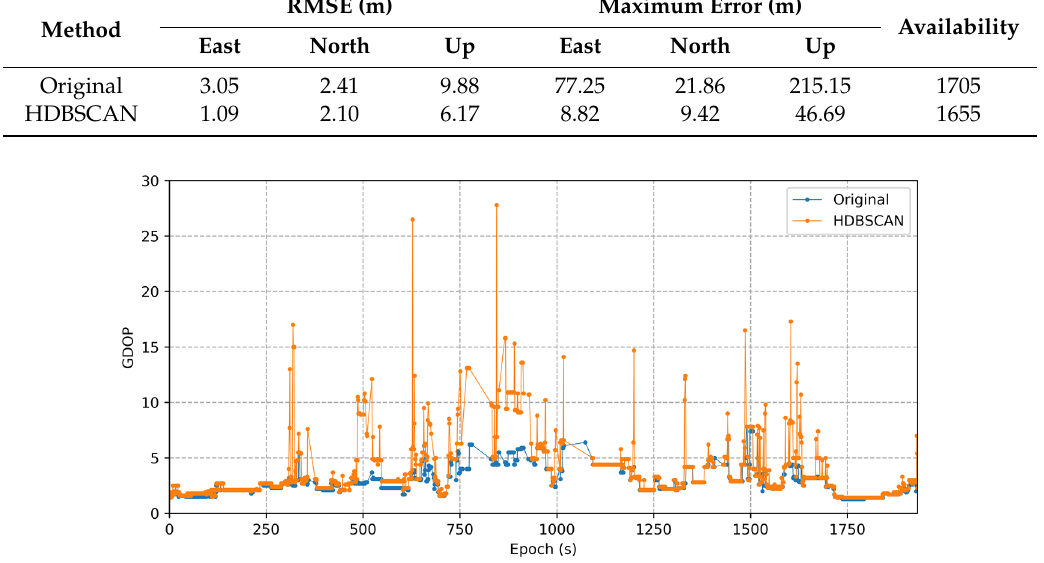
Figure 8. Comparison of positioning errors before and after excluding anomalous observations. Table 3. The positioning accuracy and availability of D1a using HDBSCAN anomaly detection and exclusion.